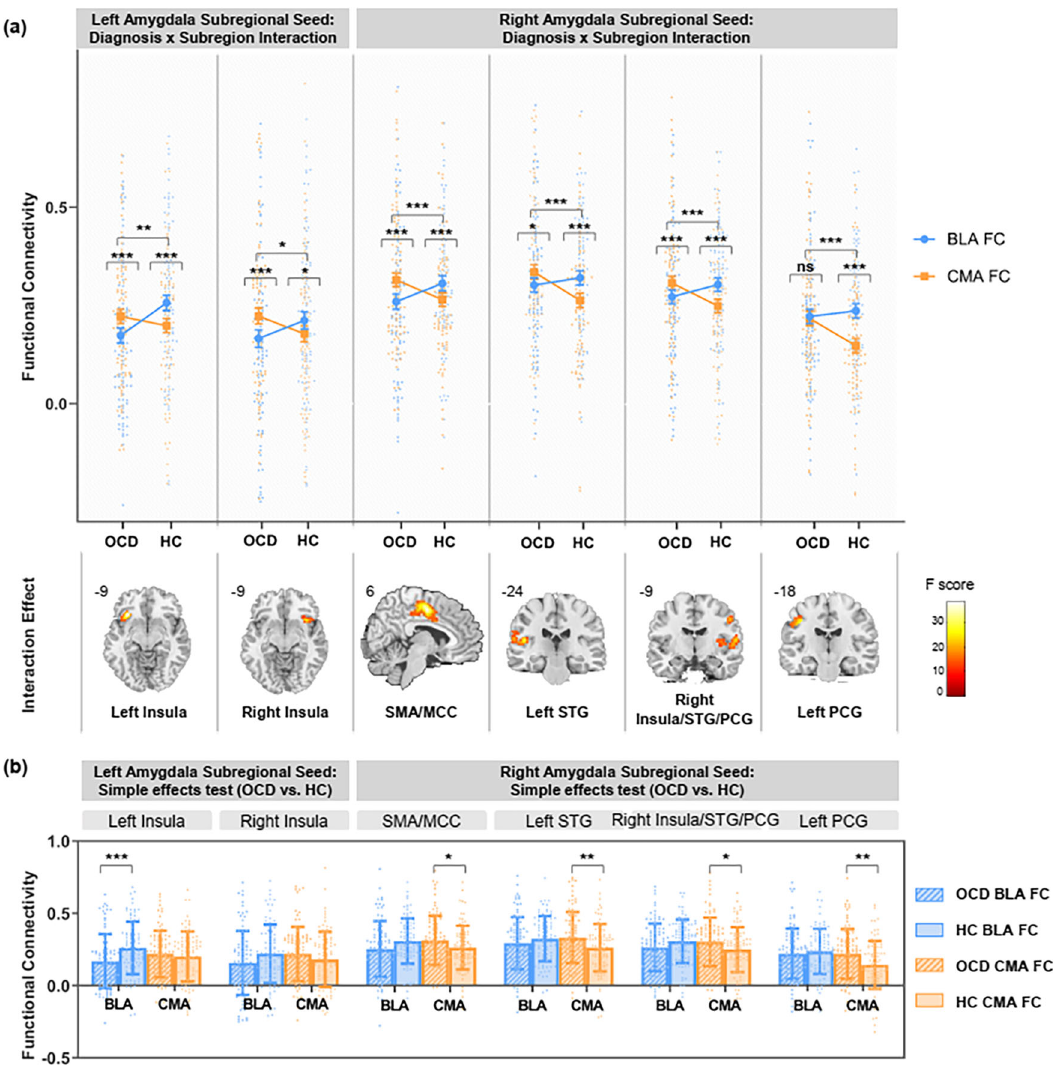
Fig. 2 Amygdala subregional functional connectivity in OCD and HC. a Signi fi cant interactions between diagnosis (OCD vs. HC) and subregion (BLA vs. CMA) computed separately in left and right amygdala. Error bars represent standard errors of the means. b Simple effects tests comparing functional connectivity (FC) between OCD versus HC in each subregion. Signi fi cance is indicated for uncorrected * p < .05, ** p < .01, *** p < .005. Error bars represent standard deviation. n = 182 biologically independent samples were used to derive statistics. MCC midcingulate cortex, PCG postcentral gyrus, SMA supplementary motor area, STG superior temporal